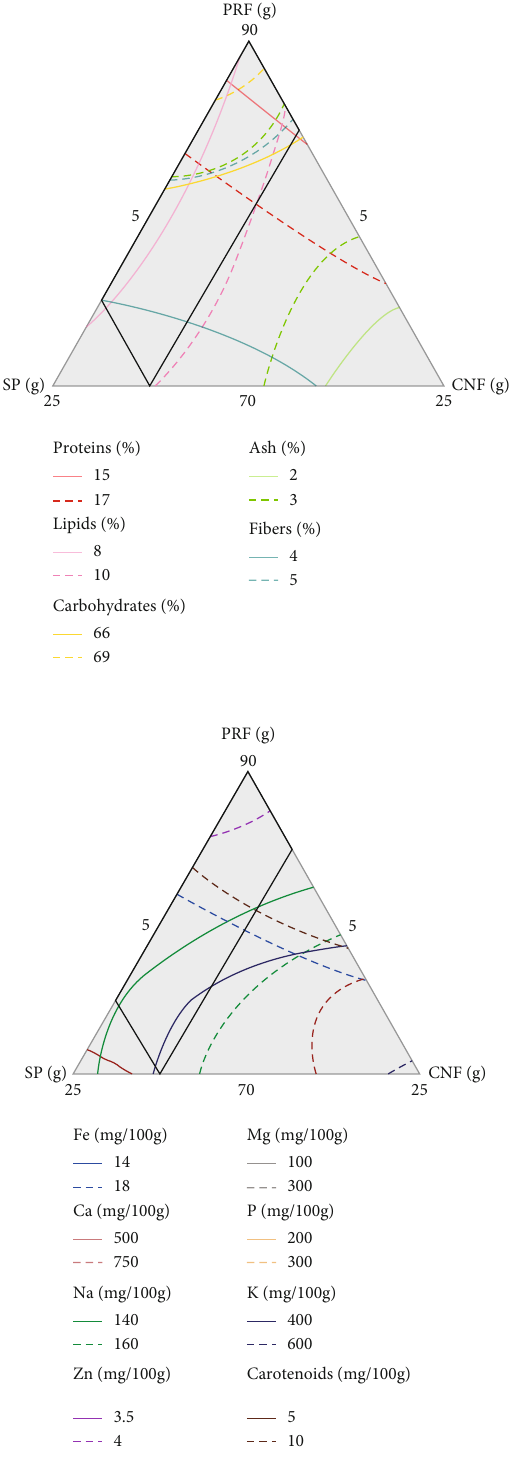
Figure 1: Overlaid contour plots for optimum composition for weaning fl our.